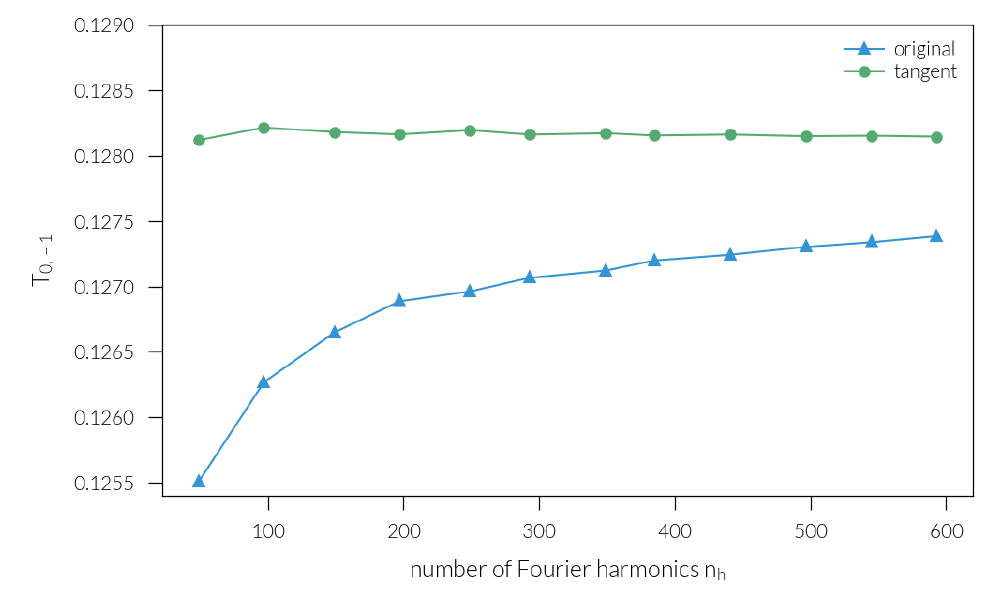
Figure A2. Convergence of the (0, − 1) transmitted order as a function of truncation number. Blue triangles: original formulation; green circles: tangent formulation.